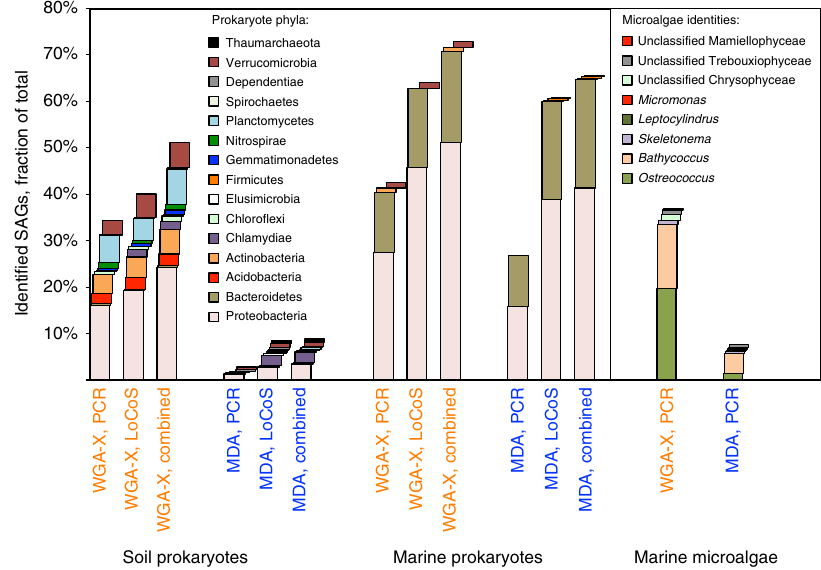
Fig. 2 Taxonomic assignments of environmental microbial SAGs. The following approaches were used: PCR-based sequencing of SSU rRNA genes followed by classi fi cation with CREST (prokaryotes) or Silva Incremental Aligner (microalgae); LoCoS followed by CheckM, Metaxa, and CREST; and a combination of the two approaches. 317 SAGs from each environment, cell type, and gDNA ampli fi cation method were